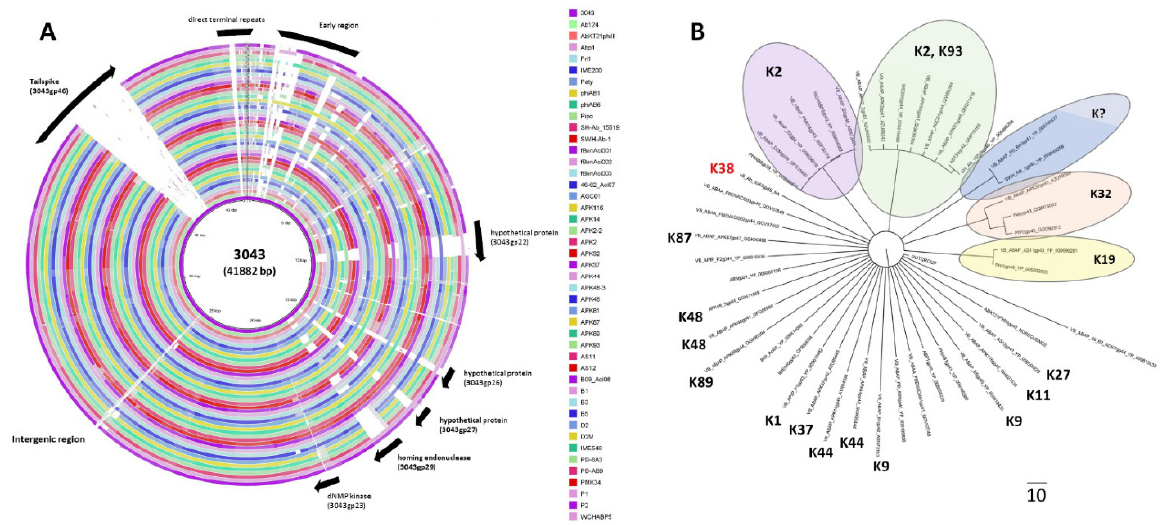
Figure 5. Horizontal movement of Acinetobacter fri1-like phage tailspikes. ( A ) Comparative genomics maps of all 45 fri1- like viruses deposited in GenBank (June 2021), plus the newly isolated phage 3043-K38 and ( B ) phylogenetic relationships of their predicted capsular depolymerase (pectate lyase 3) domains located at the tailspikes, using Muscle multiple sequence alignments and observed by the neighbor-joining analysis (using a branch-and-bound algorithm with 100 bootstrap replicates), and using the E. coli phage K1F capsule depolymerase (YP_338127) as an outgroup. Colors identify clusters of depolymerase sequences predicted to target similar capsule types.